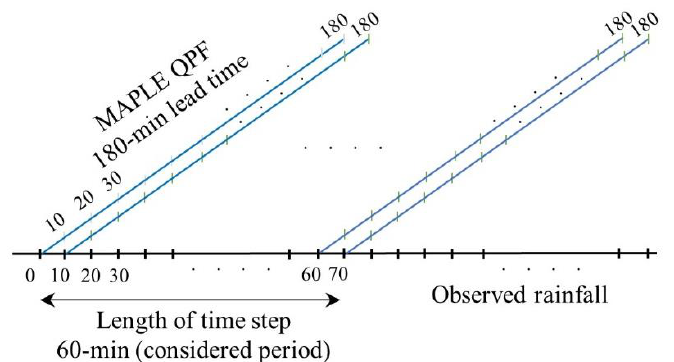
Figure 2. Data preparation for the training stage between the MAPLE quantitative precipitation forecasts (QPFs) and observed rainfall at each station in an event. The considered period presents the period in which QPFs can be extracted.